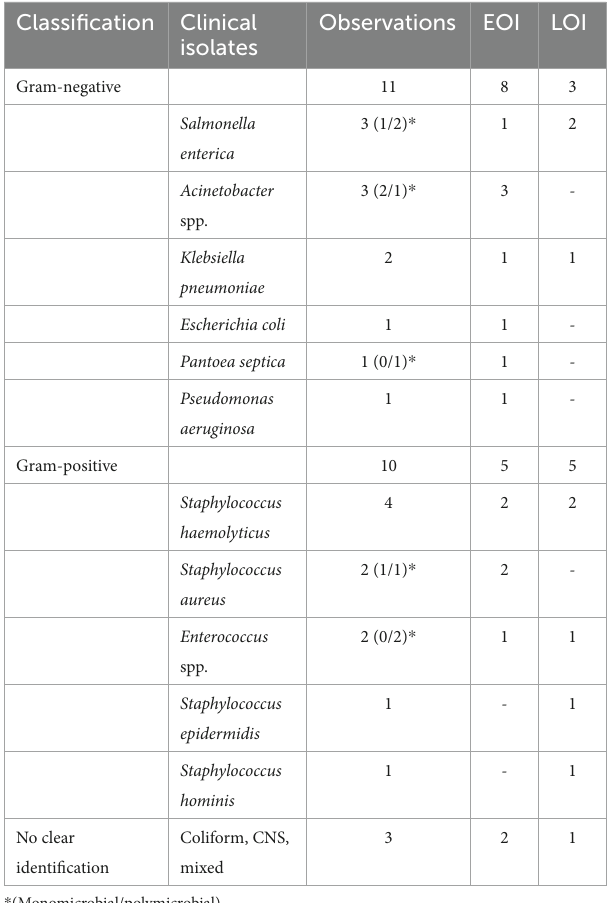
TABLE 2 Identified bacterial species in blood cultures using MALDI-TOF